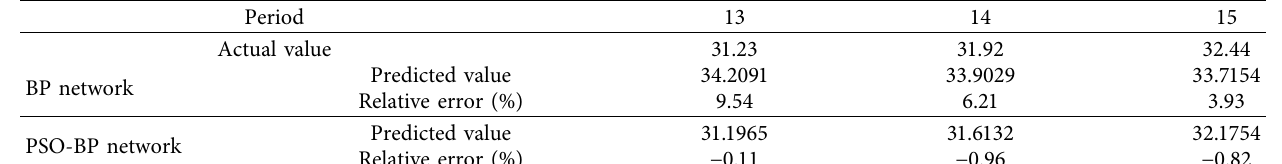
Table 13: B16 actual value and predicted value comparison results.